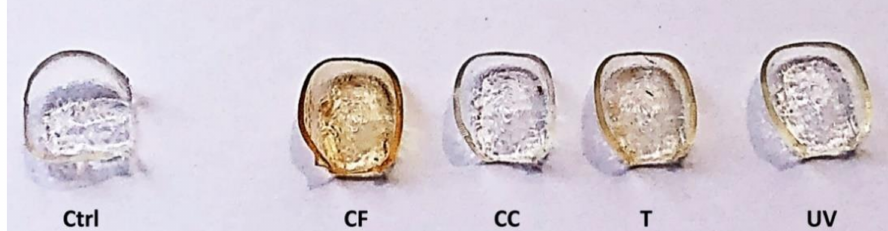
Figure 2. Invisalign ® aligners portions after 48 h of treatments with coffee (CF), Coca Cola ® (CC), tea (T) and UV radiation (UV), compared to the control